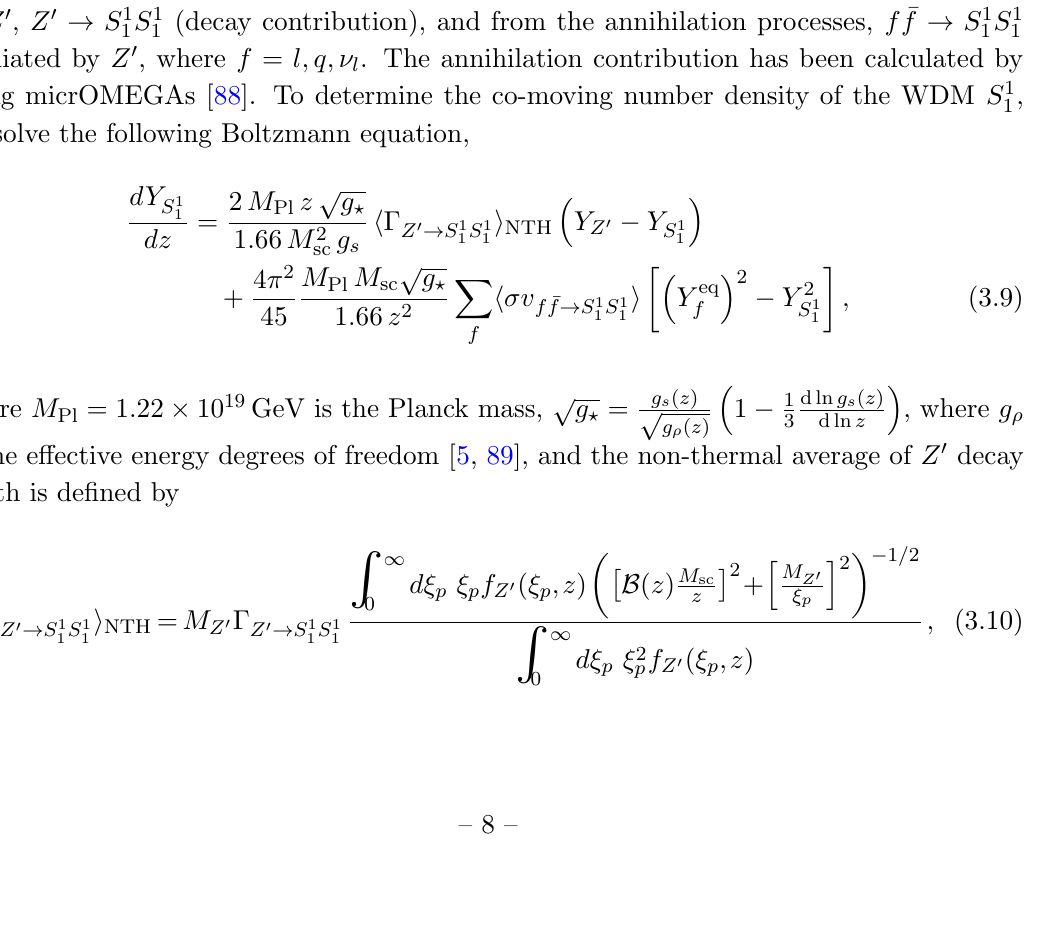
= 1 TeV, M = S 1 1 2